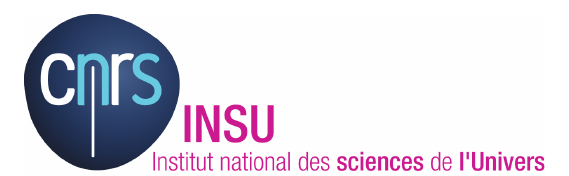
Fig. 11. (a) Topography scan of a developed braided river system, with flow direction from top to bottom of the image, and (b) scan repeated five minutes later. By subtracting the first scan from the second, we can produce (c) a map of the erosional and depositional features of the